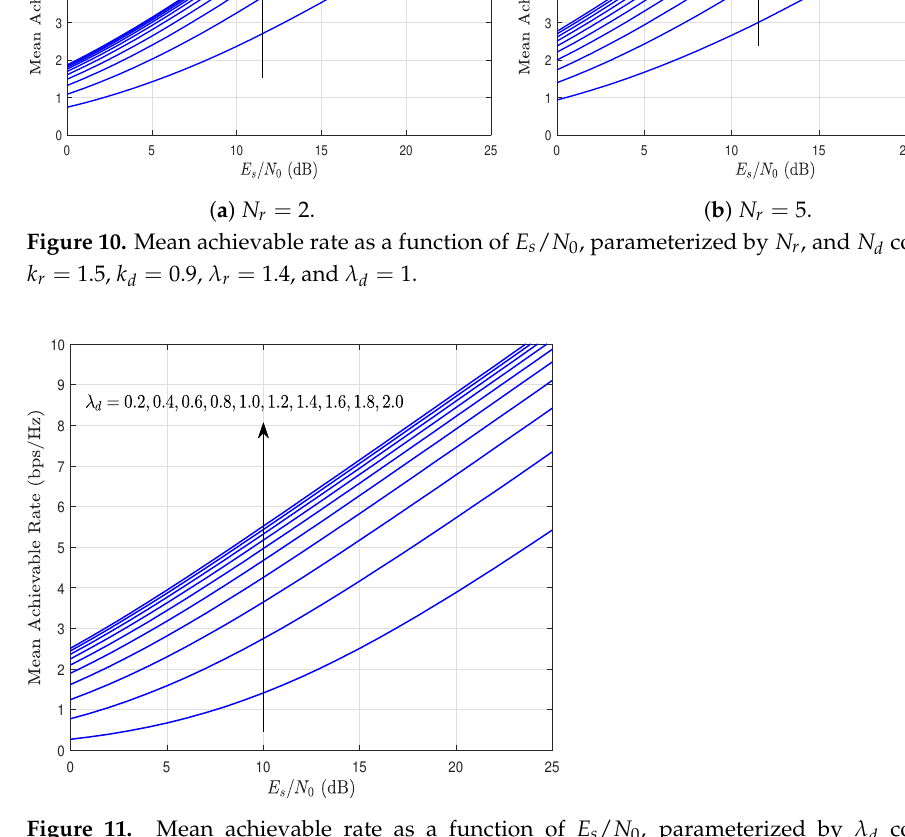
Figure 11. Mean achievable rate as a function of E s / N 0 , parameterized by λ d considering N r = N d = 4, k r = 1.5, k d = 0.9, and λ r =